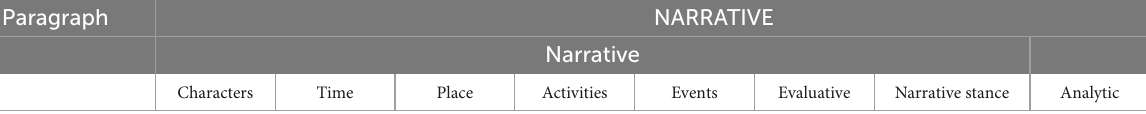
TABLE 3 First paragraph in five